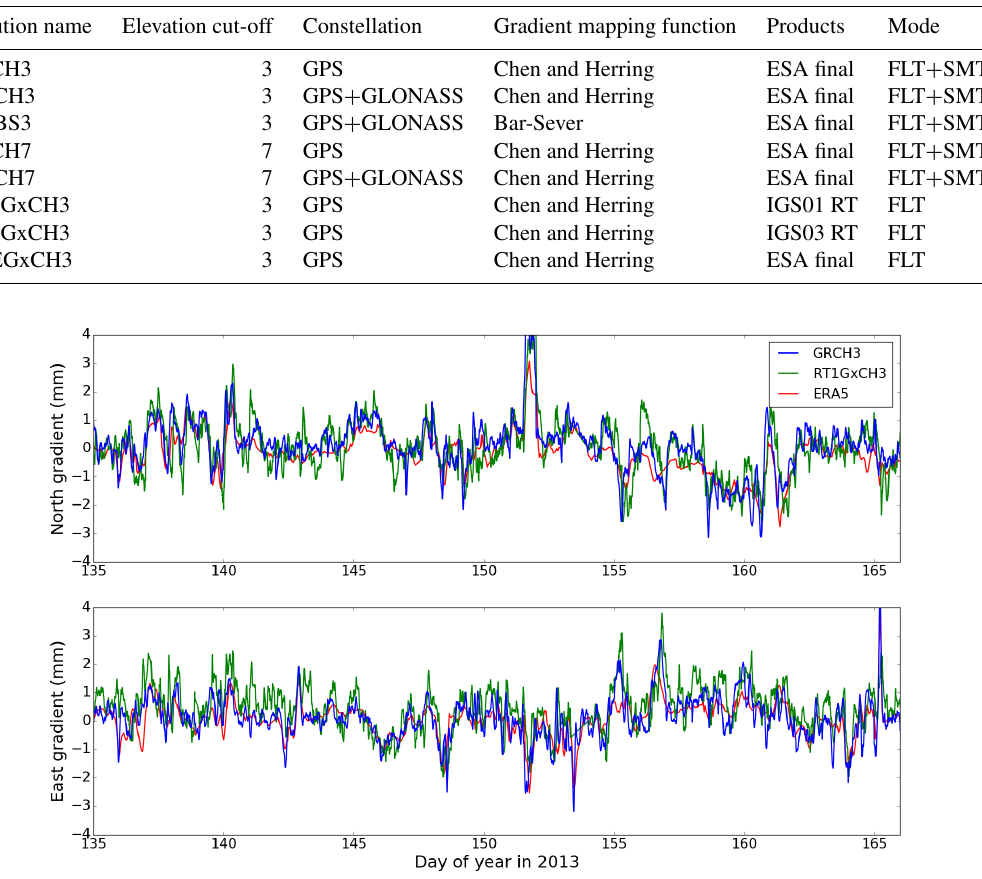
Figure 2. Tropospheric gradients retrieved from GNSS data processing (GRCH3, RT1GxCH3) and from NWM ERA5 at station LDB2 (52.209 ◦ N, 14.121 ◦ E, Germany) for a period from 15 May till 15 June